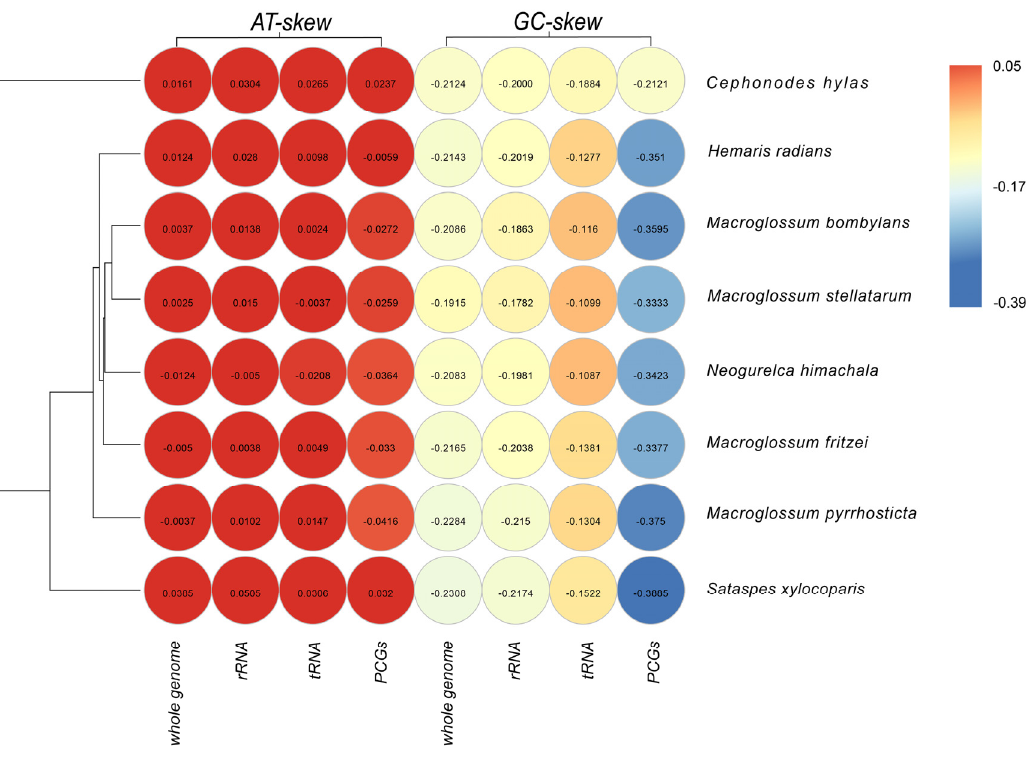
Figure 1. Nucleotide composition of various datasets of mitogenomes. Hierarchical clustering of eight diurnal hawkmoths based on the AT − skew and GC − skew.